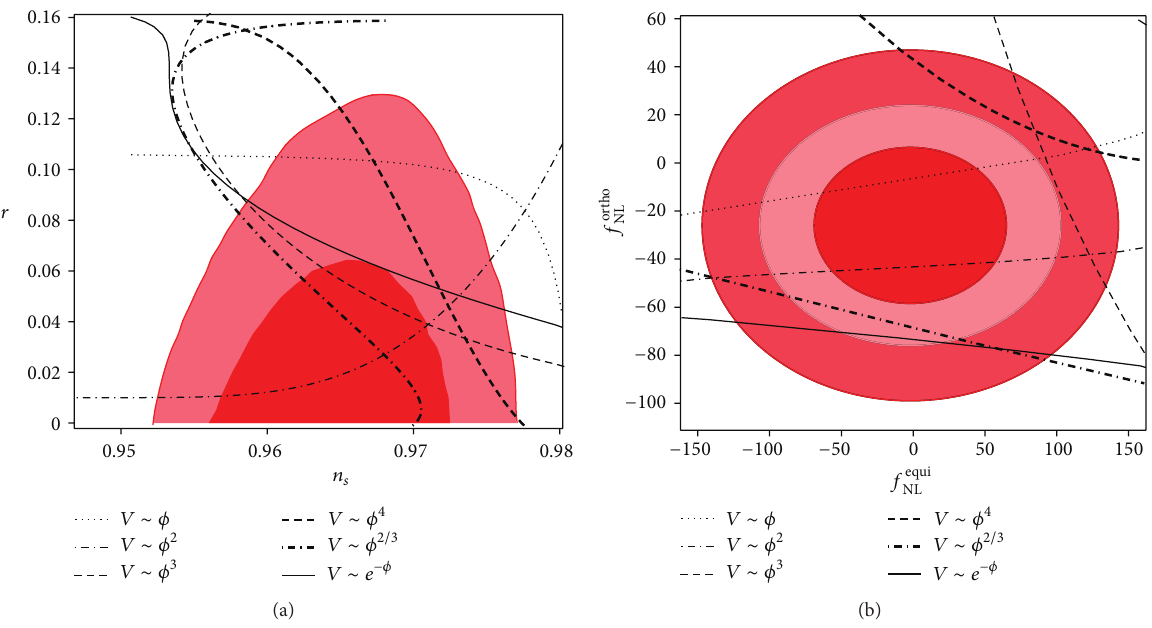
Figure 5: Tensor-to-scalar ratio versus the scalar spectral index for an inflationary model in which both inflaton and its derivative are nonminimally coupled to gravity, in the background of Planck 2015 TT, TE, and EE + lowP data (a) and the amplitude of the orthogonal configuration versus the amplitude of the equilateral configuration of non-Gaussianity for an inflationary model in which both inflaton and its derivative are nonminimally coupled to gravity, in the background of Planck 2015 TTT, EEE, TTE, and EET data (b). Figure is plotted with 𝑛 = 3 , 𝑓(𝜙) ∼ 𝜉𝜙 2 , and various types of potential, for 𝑁 = 60